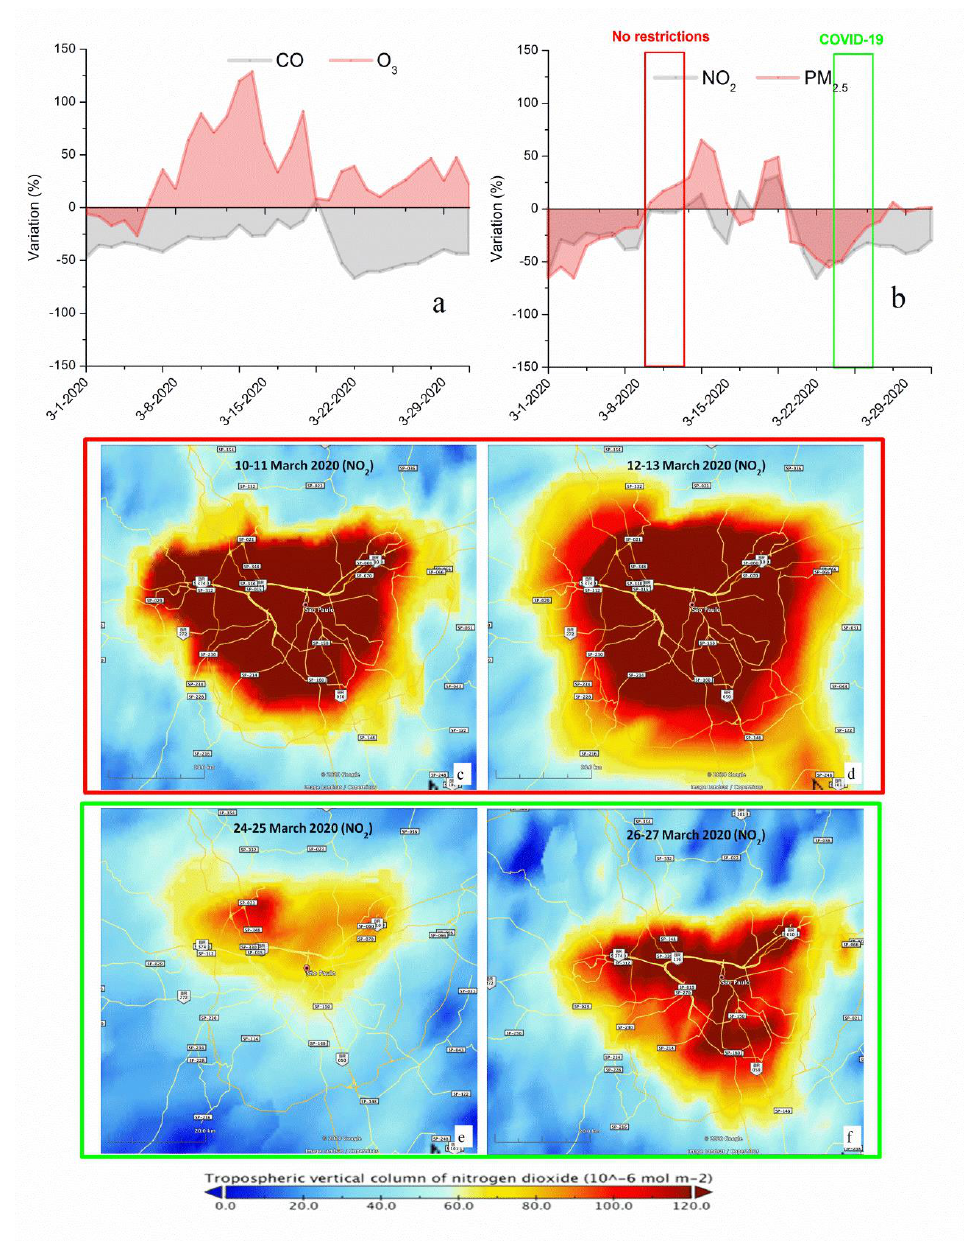
Figure 6. Variations for each March day of 2020 compared to a baseline value, median of March concentration levels of years 2015–2019 for São Paulo MA, ( a ) CO and O 3 , ( b ) NO 2 and PM 2.5 . Highlighted periods in red and green correspond to maps c, d and e, f, respectively. Maps of NO 2 columns elaborated from satellite data from the European Space Agency, Tropomi Copérnico Sentinel 5P. ( c , d ) represent a period before the confinement. ( e , f ) correspond to the period of activity restriction (COVID-19 scenario).